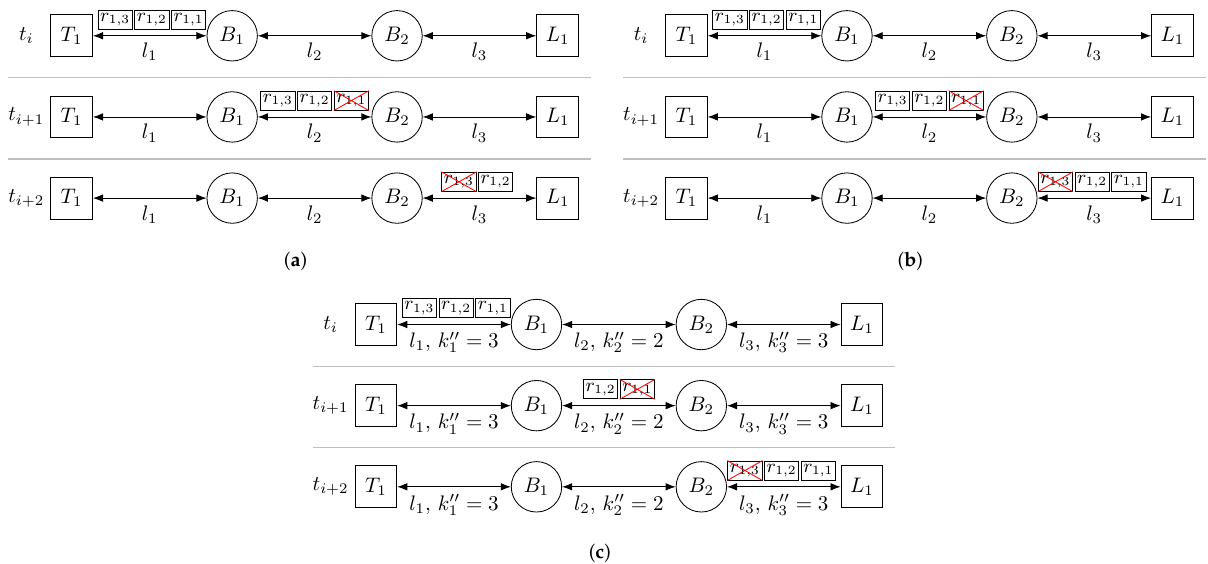
Figure 3. Behaviour of the three approaches of PTRF in the presence of temporary faults in the links. Reproduced as in [11]. ( a ) Behaviour of the approach A in the presence of temporary faults in the links. ( b ) Behaviour of the approach B in the presence of temporary faults in the links. ( c ) Behaviour of the approach C in the presence of temporary faults in the